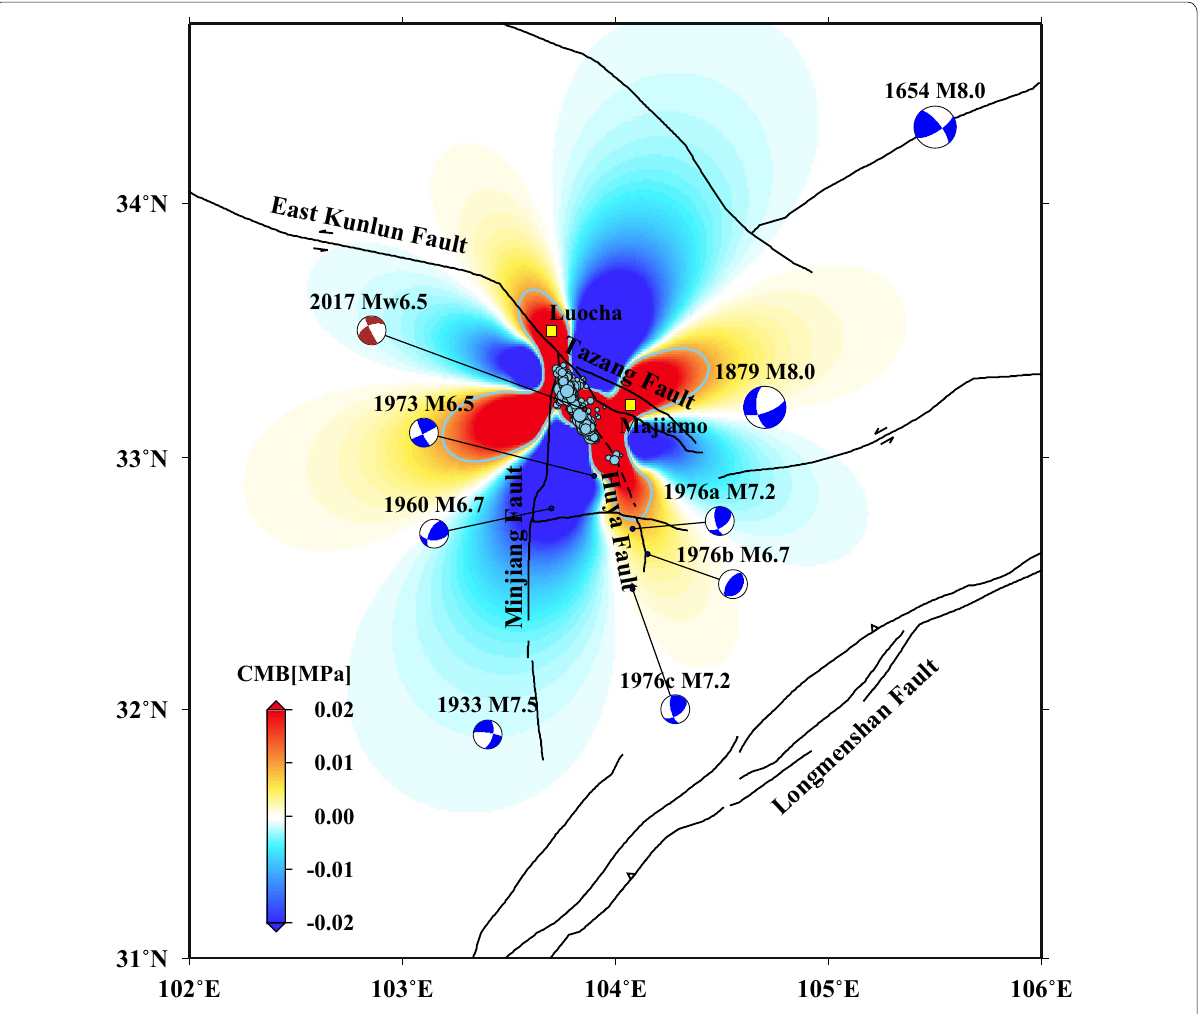
Fig. 7 Coseismic Coulomb stress changes of the Jiuzhaigou